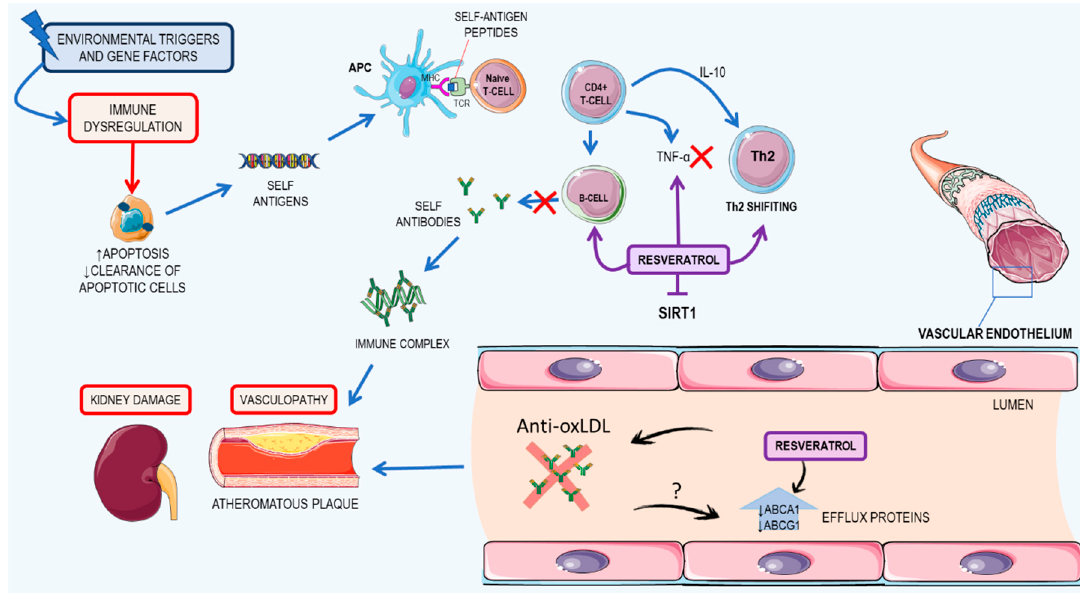
Figure 7. Summary of the pathogenesis of systemic lupus erythematosus (SLE) and resveratrol mechanisms of action. The immune dysregulation caused by environmental triggers and genetic predisposition leads to increased apoptosis. Decreased clearance causes recognition of self-antigens by the immune system, activation of B and T cells, and the production of self-antibodies. Those antibodies, mainly IgG, cause the formation of immune complexes that can lead to renal impairment in kidneys and vasculopathy and atheromatous plaque formation in blood vessels. Atheroma plaques are caused by the action of anti-oxidized low-density lipoprotein (LDL), which is very common in SLE, which leads to the decrease of ABCA1 and ABCG1 by a yet unknown mechanism. Resveratrol acts as an SIRT1 activator, inhibiting proliferation of B and T cells and antibody production and also increasing ABCA1 and ABCG1 levels. ABCA1: ATP-binding cassette transporter A1; ABCG1: ATP-